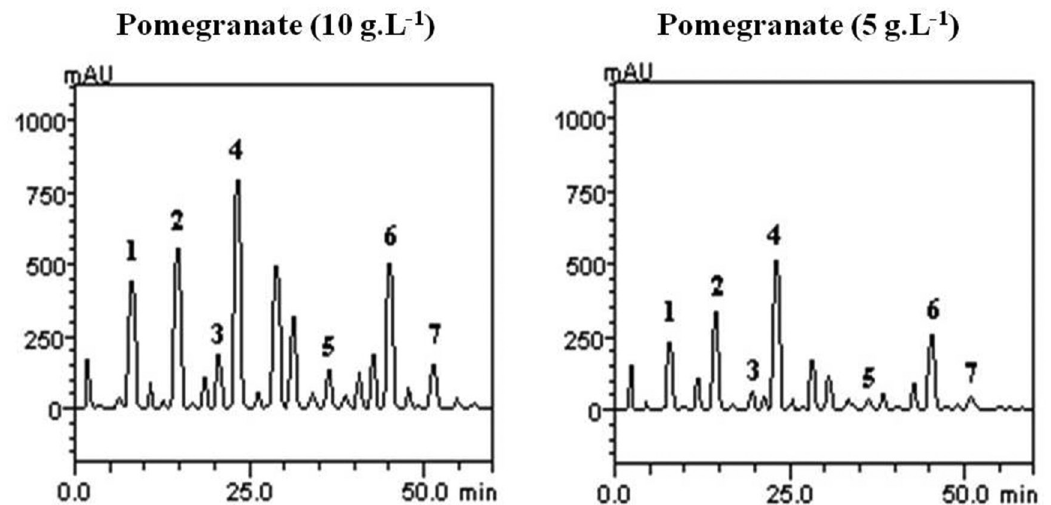
FIGURE 4 - Chromatographic profile of Punica granatum , UV detection at 327 nm. Gallic acid (peak 1), catechin (peak 2), chlorogenic acid (peak 3), caffeic acid (peak 4), quercetin (peak 5), rutin (peak 6), and kaempferol (peak 7). Chromatographic conditions are described in methods. TABLE III – Composition of phenolic and flavonoid compounds of Punica granatum